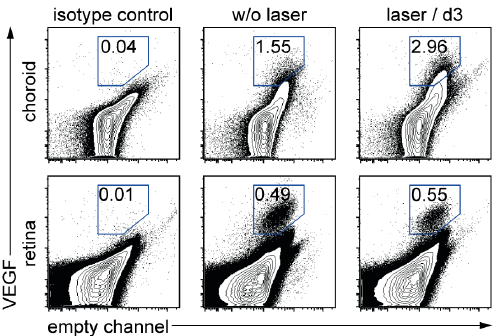
Figure 1. Flow cytometric analysis of VEGF-containing eye cells in the choroid and the retina. VEGF-containing eye cells from the choroid and the retina of untreated (middle) and laser-treated (right) mice are shown. Specificity was verified by an isotype control (left). Cells positive for VEGF were plotted versus an empty fluorescence channel. Percentages are means of the respective group. Dot-plots display representative data from one of two independent experiments. A total of 4–5 mice were used per group in each of these experiments